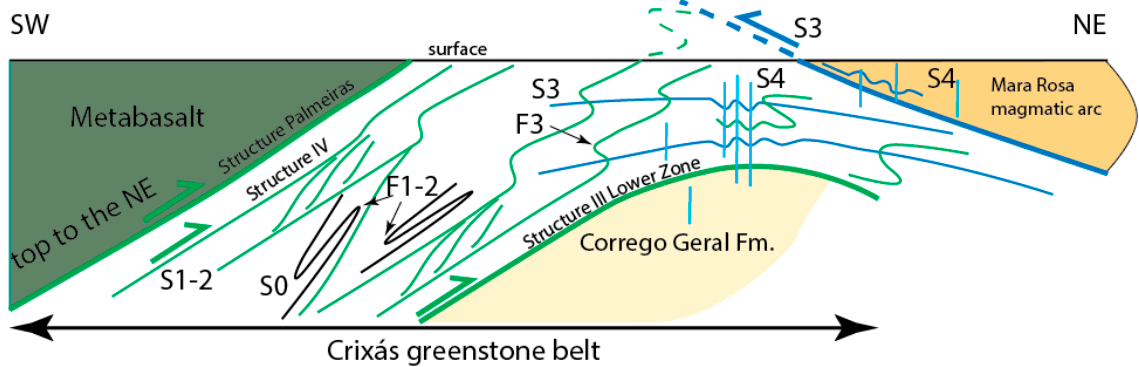
Figure 5. A summary sketch of the current structural framework.